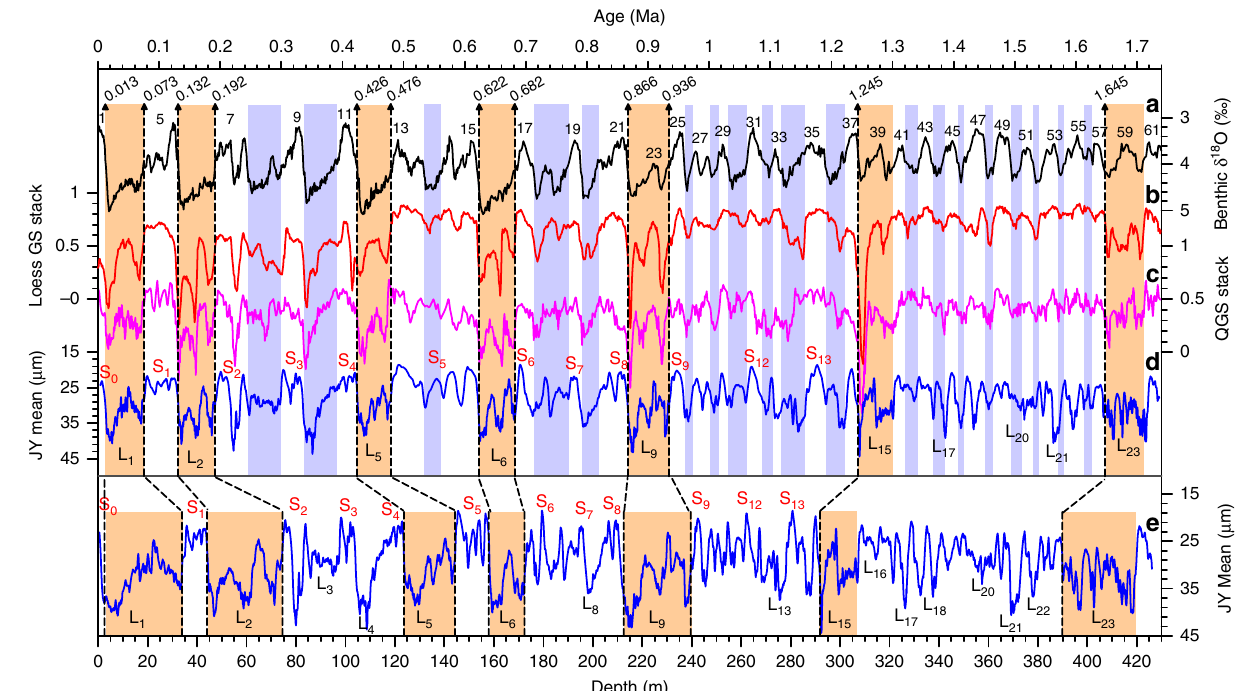
Fig. 3 Comparison of JY grain-size time series with stacked loess grain-size and benthic δ 18 O. a Benthic δ 18 O stack 3 . b Loess grain-size (GS) stack 25 . c Quartz grain-size (QGS) stack 26 . d JY mean grain-size on age scale. e JY mean grain-size on depth scale. Dashed lines denote that the chronology was generated by matching the timing of seven loess marker layers (L 1 , L 2 , L 5 , L 6 , L 9 , L 15 , and L 23 ) to stacked grain-size time series. Orange and blue bars indicated the correlation of thick marker layers and other loess units to glacial